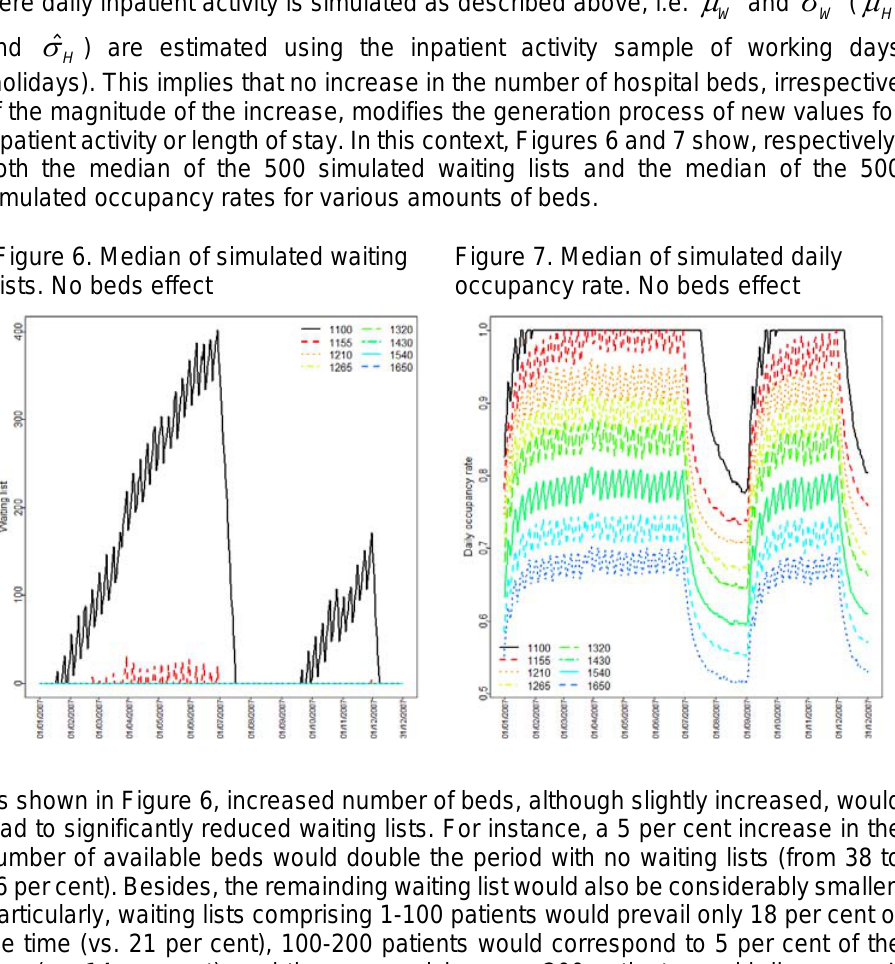
Figure 6. Median of simulated waiting lists. No beds effect